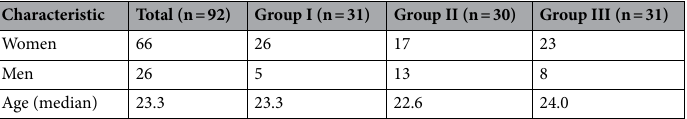
Table 1. Demographic characteristics of study